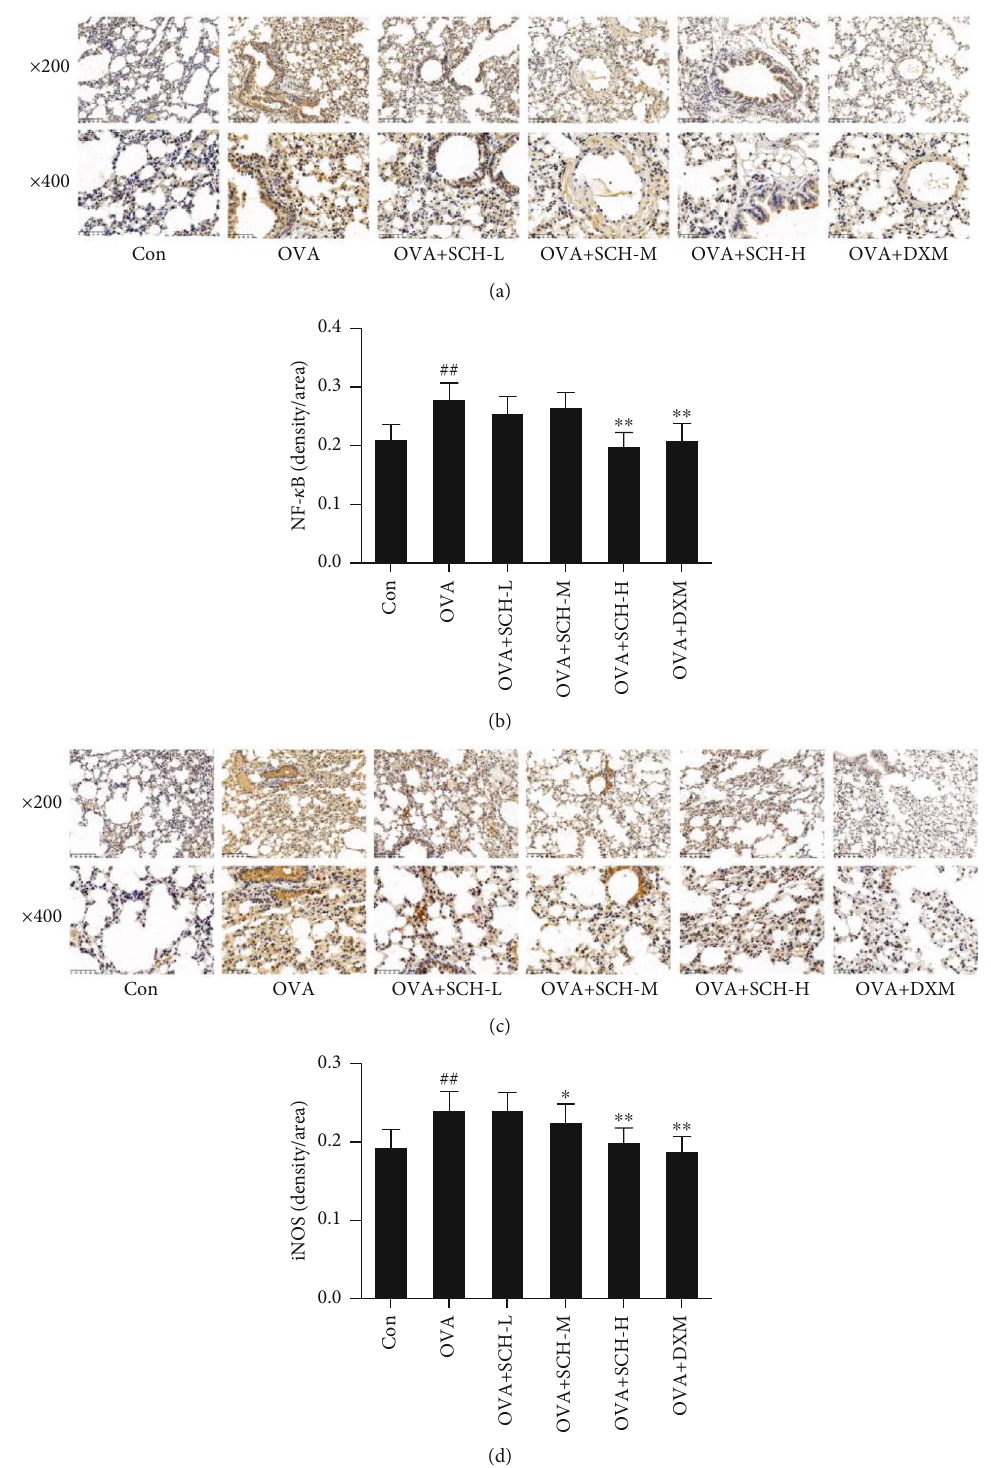
Figure 8: E ff ect of SCH on the levels of NF- κ B and iNOS. (a and c) The levels of NF- κ B and iNOS in lung tissues were detected using immunohistochemistry. (b and d) Quanti fi cation of the average density of NF- κ B and iNOS. At × 200 magni fi cation, scale bars represent 100 μ m. At × 400 magni fi cation, scale bars represent 50 μ m. Data are presented as the means ± SD ; n = 6 . ## p < 0 : 01 compared with the control group; ∗∗ p < 0 : 01 and ∗ p < 0 : 05 compared with the OVA